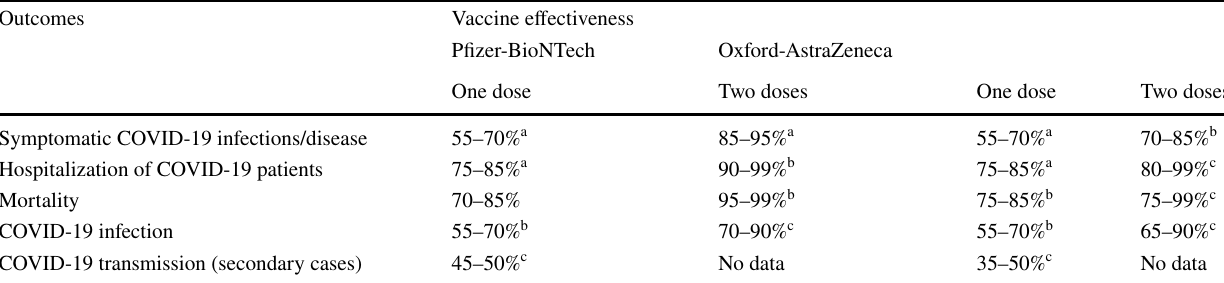
Table 5 Comparative analyses of vaccine effectiveness against different outcomes of dominant SARS-CoV-2 alpha VOCs [15, 16]